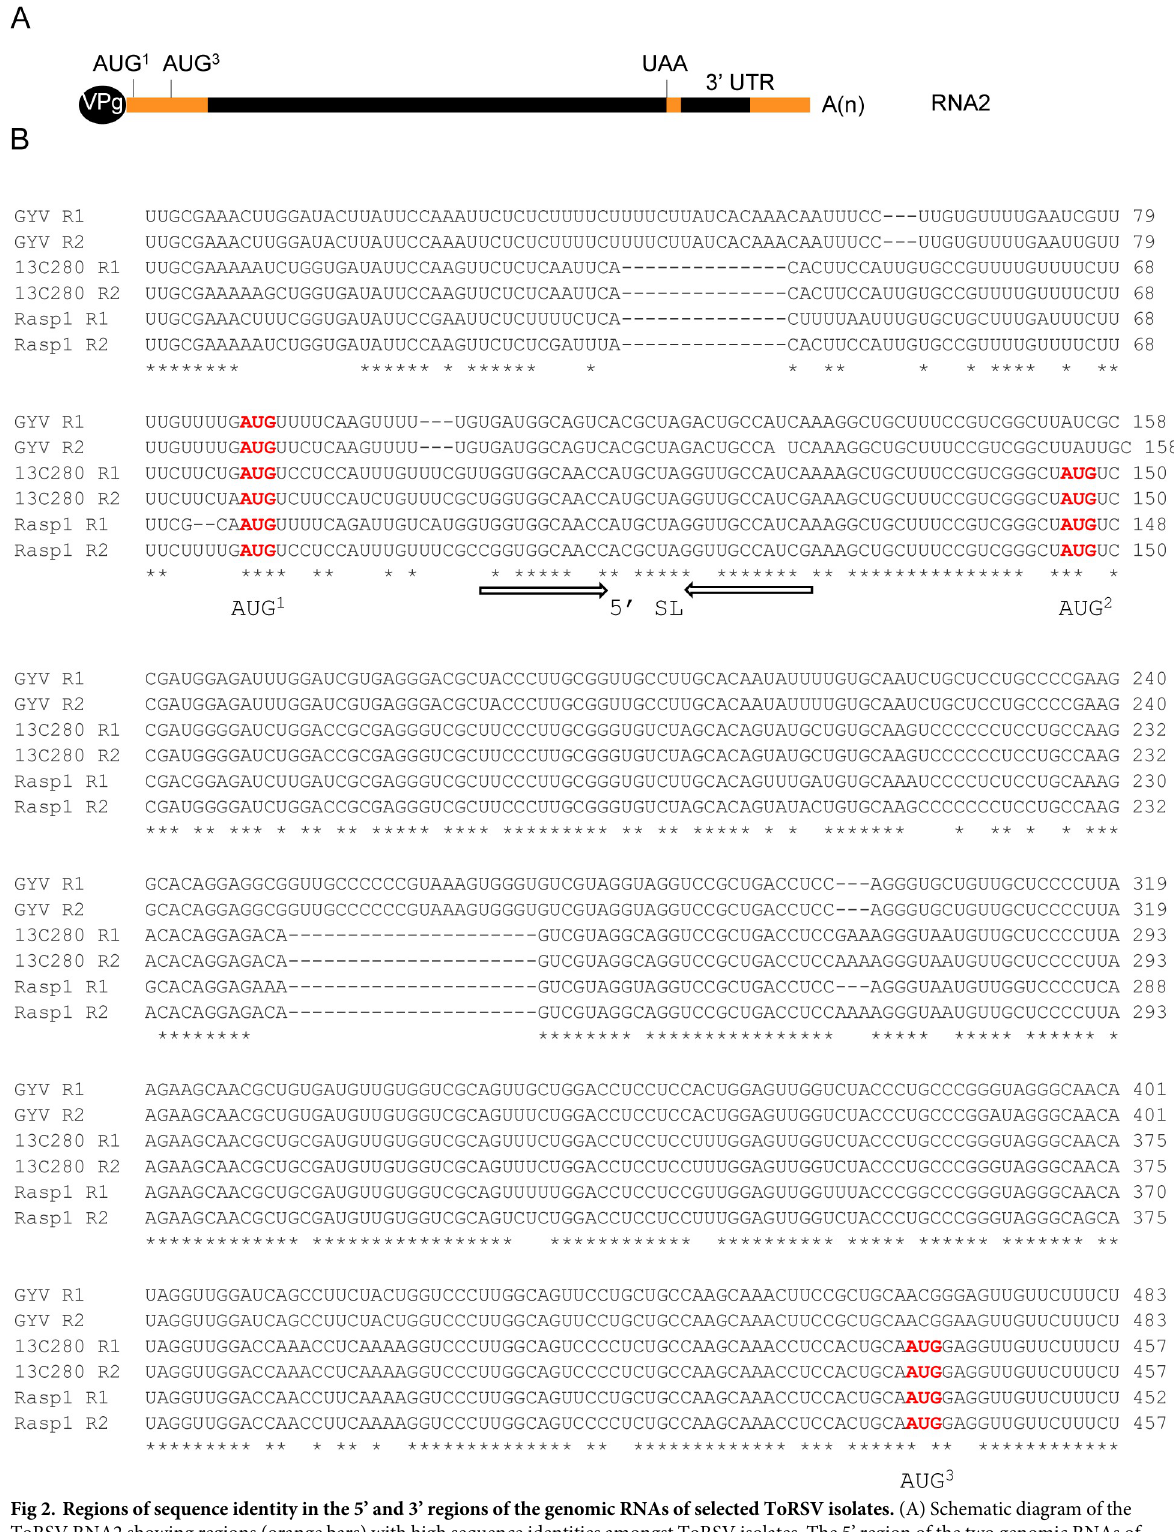
PLOS ONE | https://doi.org/10.1371/journal.pone.0249928 April 9,